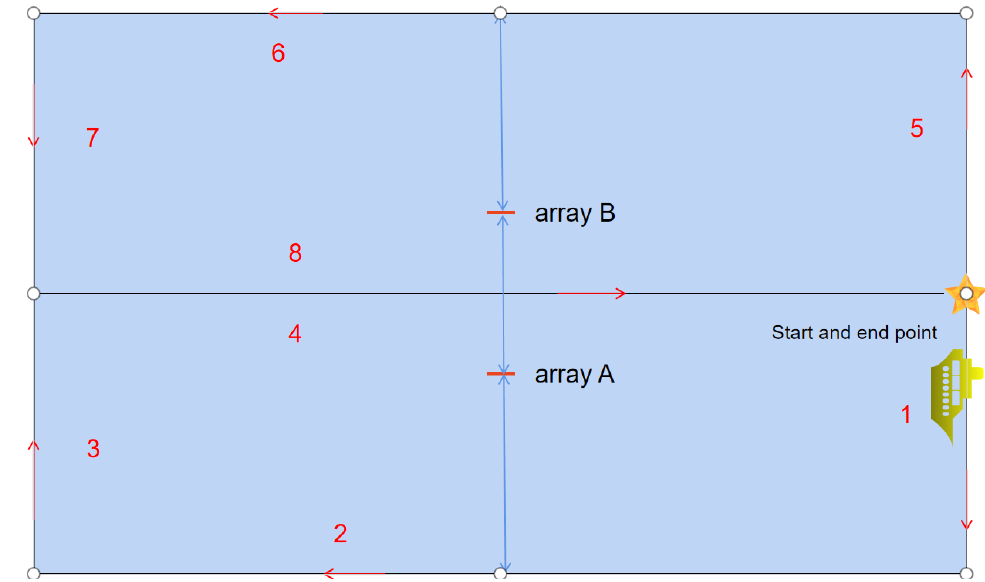
Figure 9. Ship trajectory map. The numbers 1 – 8 represent the order of the ship's track.